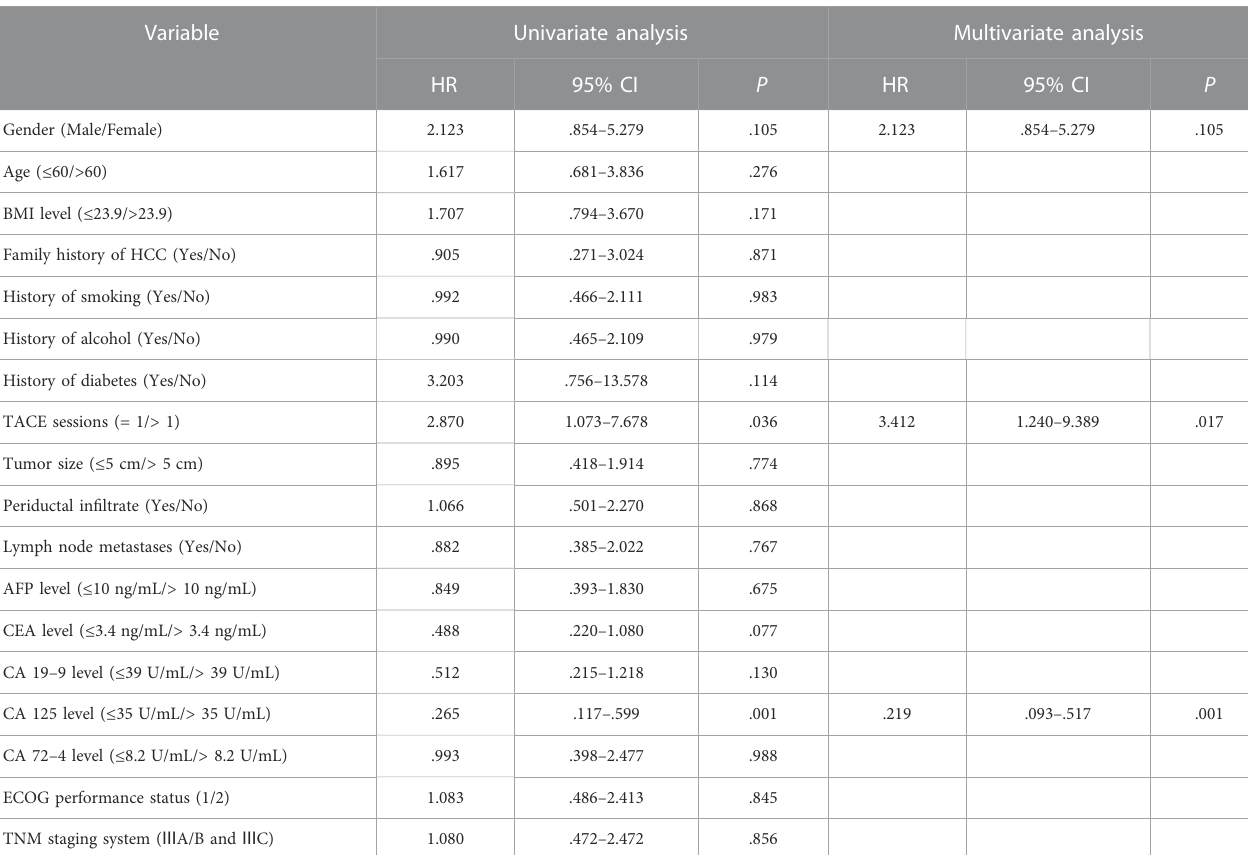
TABLE 2 Cox ’ s proportional hazards regression model analysis of factors affecting OS. Variable Univariate analysis Multivariate